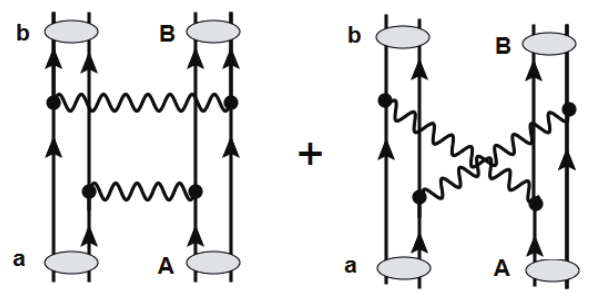
Figure 1. Schematic graphical representation of a Double Single Charge Exchange (DSCE) reaction a ( N a , Z a ) + A ( N A , Z A ) → b ( N a ± 2, Z a ∓ 2 ) + A ( N A ∓ 2, Z A ± 2 ) , proceeded by the sequential twofold action of the isovector NN T-matrix, indicated by wavy lines. Each of the interaction events acts similar to a one-body operator on the target and projectile, respectively. Note that the diagram on the right is related to left one by a change in time order. A striking formal similarity to a 2 ν 2 β nuclear matrix element (NME) is